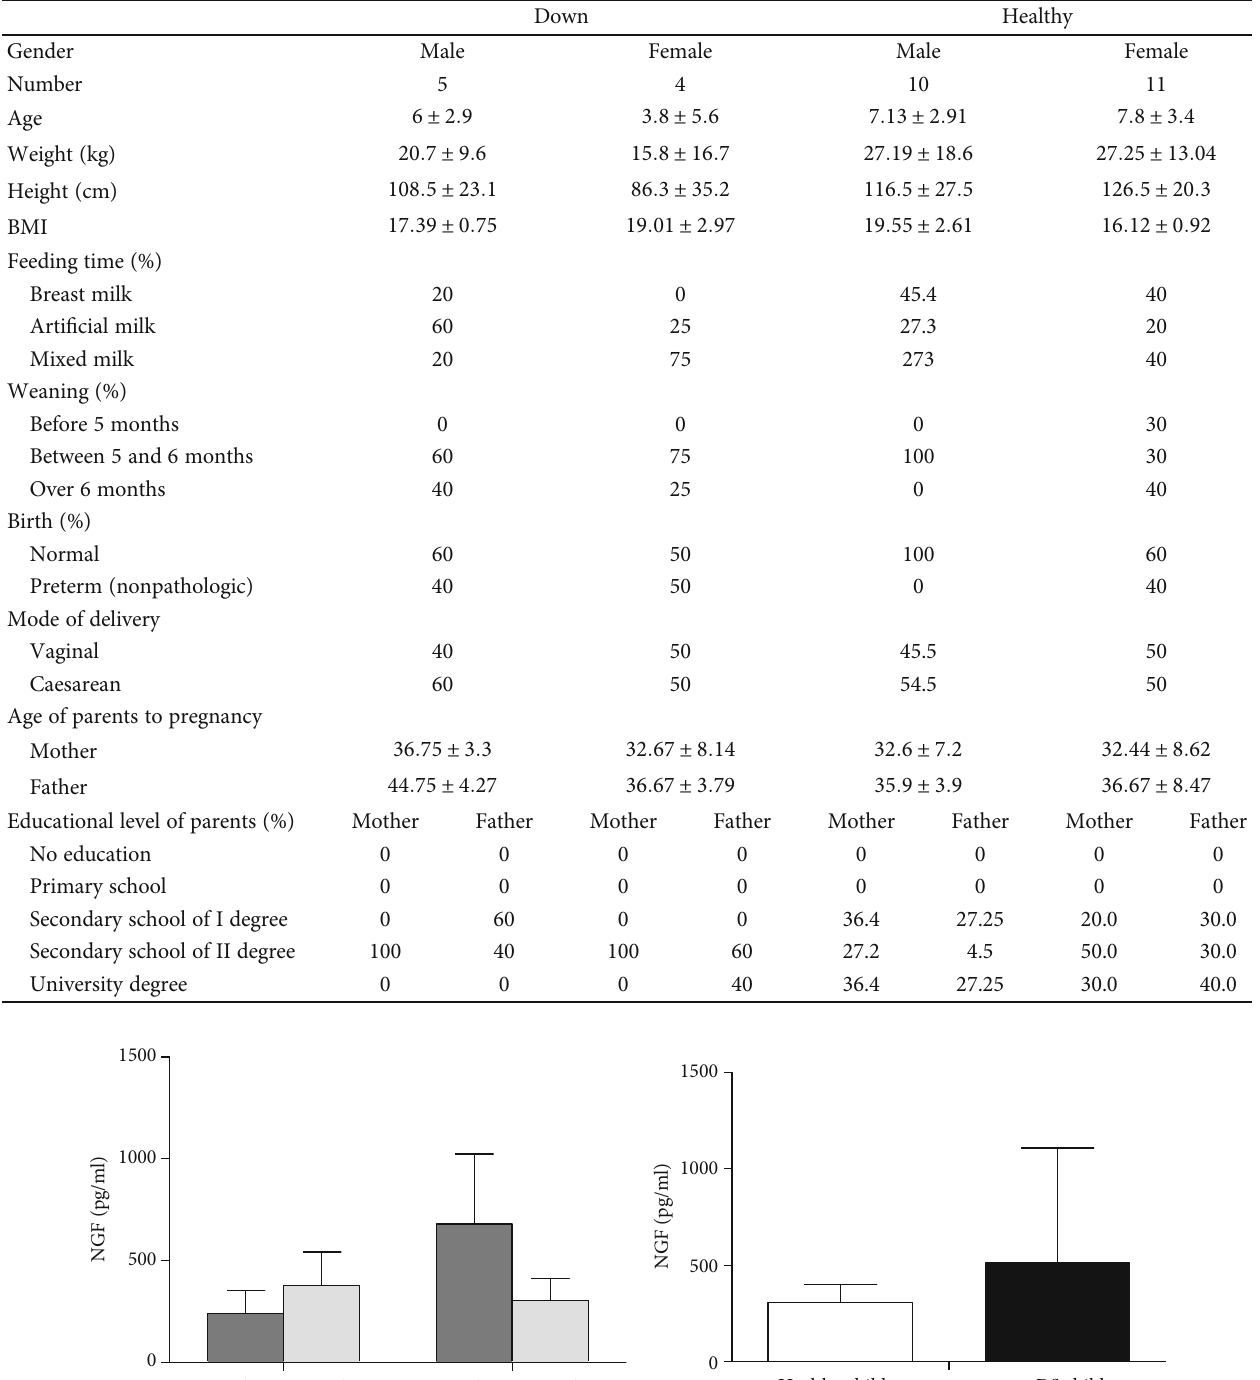
Table 1: Anamnestic and anthropometric data of the children or their parents included in the study. Data are expressed as means ± SE , as median, or as percentage.